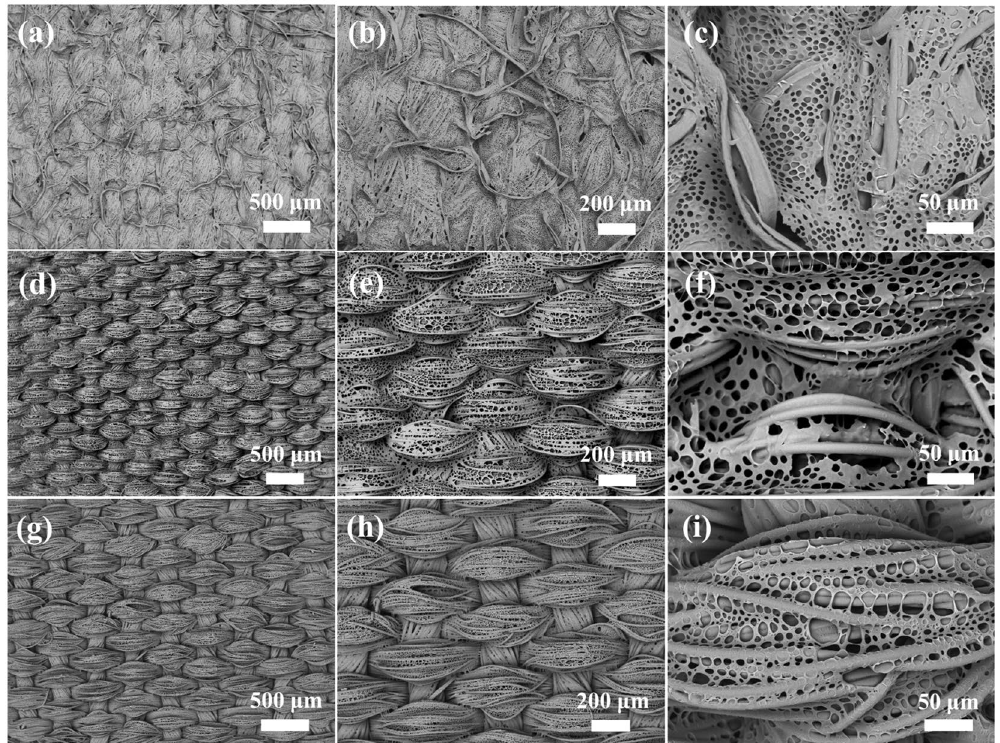
Figure 6. SEM images of CPMFs with different polymers on different fabrics: ( a–c ) PS/asphalt coated cotton fabric, ( d–f ) PS/asphalt coated polyester fabric, and ( g–i ) SBS coated polyester